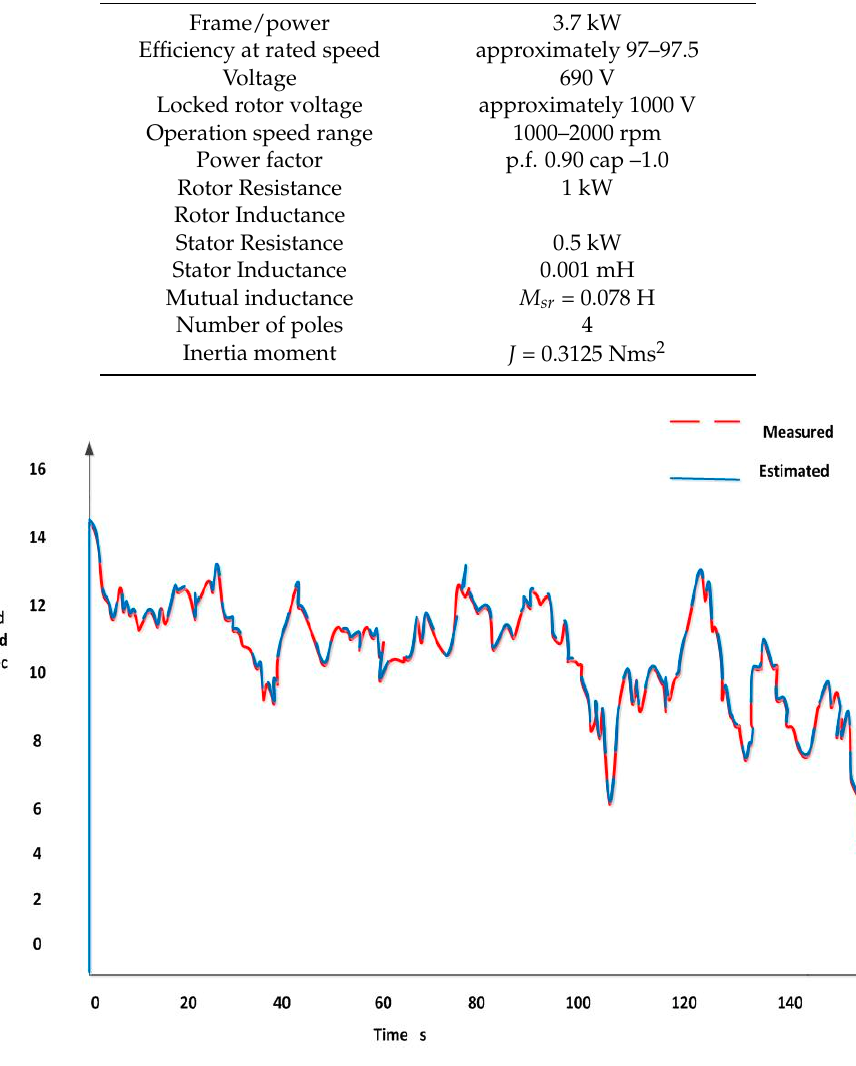
Figure 9. DFIG rotor speed estimation performance using AISE.